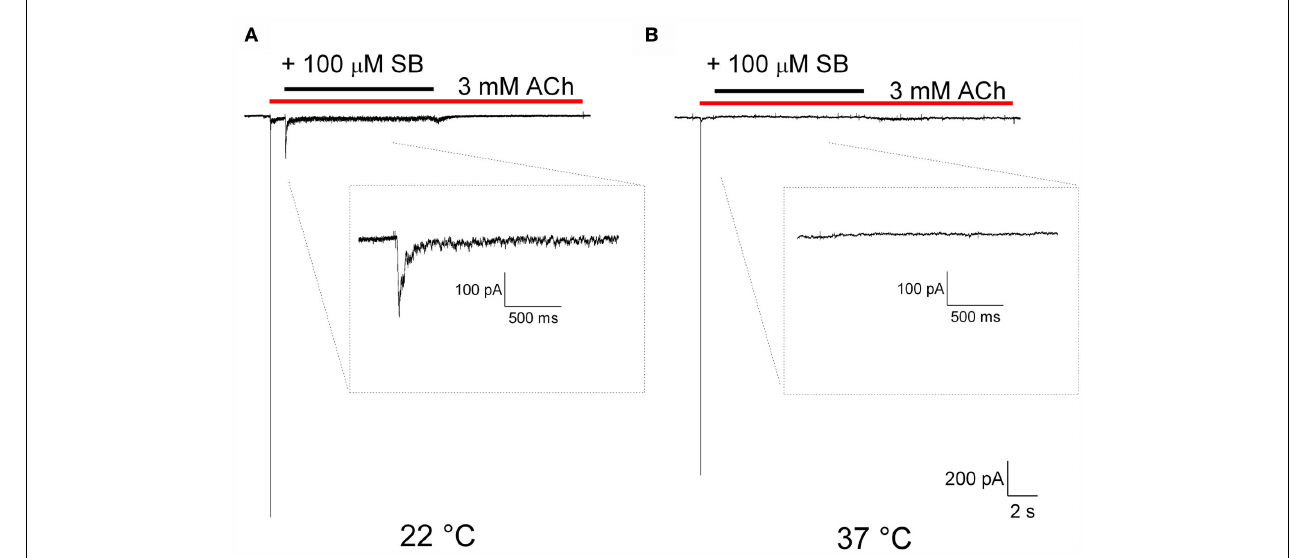
temperature, and (B) Example trace showing lack of SB-206553-mediated reversal of ACh-evoked desensitization at 37˚C, illustrating a strong temperature dependence for this SB-206553 mediated